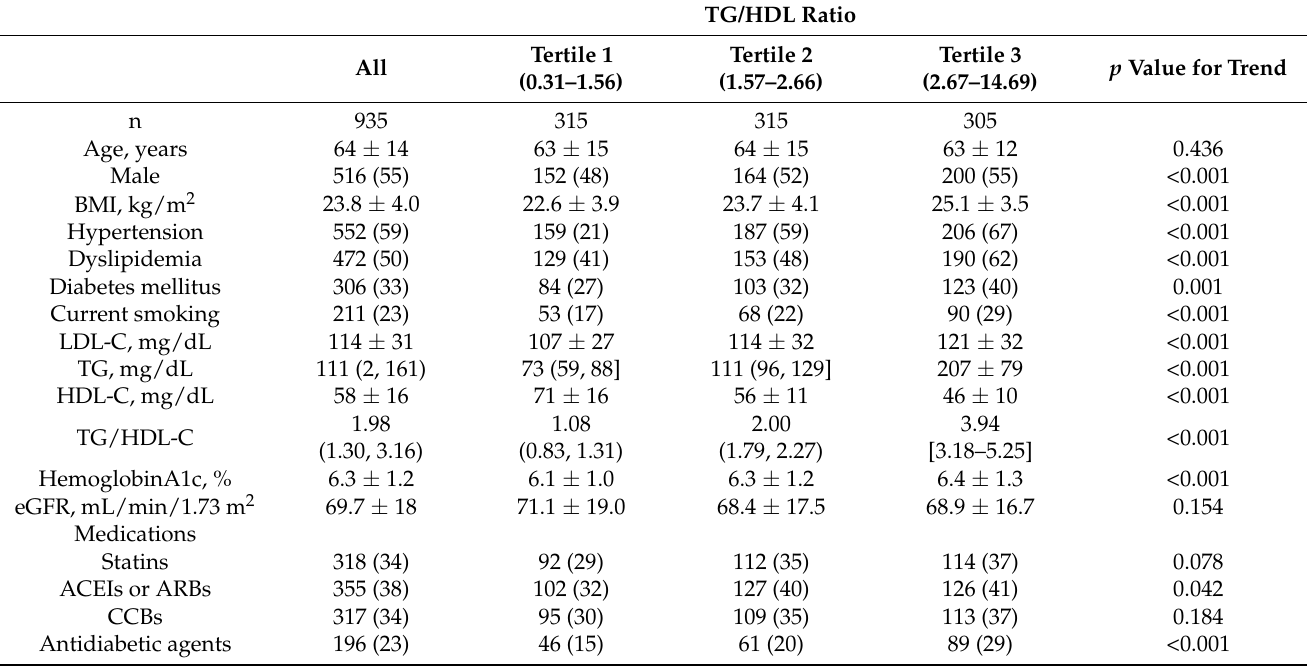
Table 1. Baseline characteristics of patients according to the TG/HDL ratio